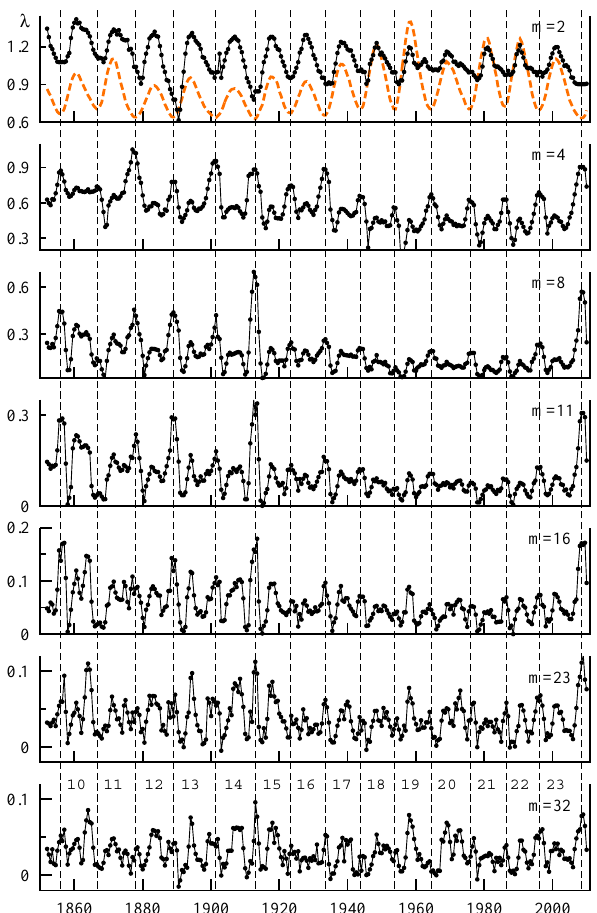
Figure B1. The irregularity index λ computed for ISSN within 4- year sliding windows; the embedding dimension m is indicated; ver- tical lines are at solar cycle